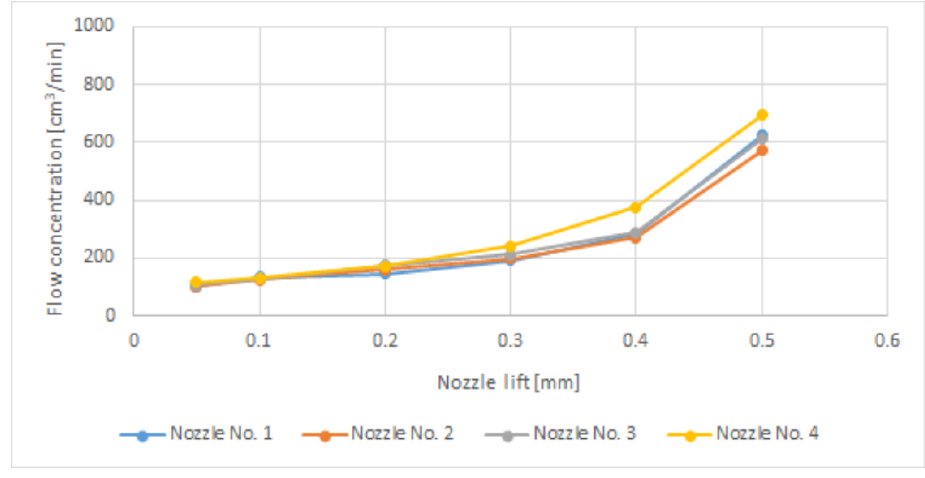
Figure 6. The flow after the test for SD1.